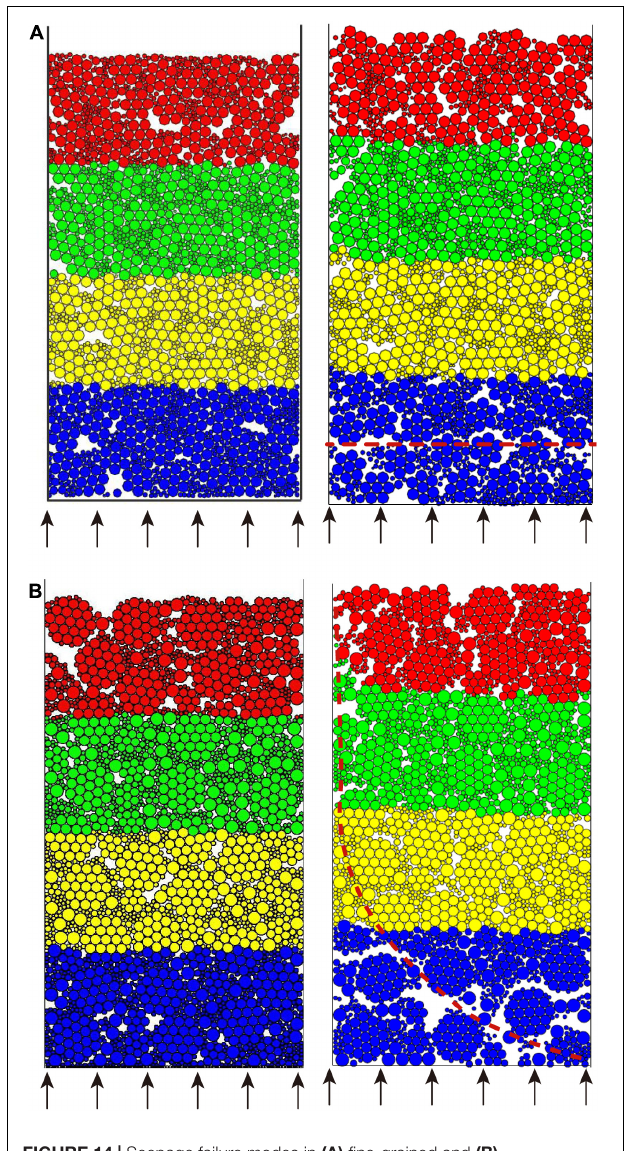
FIGURE 14 | Seepage failure modes in (A) fine-grained and (B) coarse-grained soils (Shi et al., 2018). The red dashed lines denote the seepage failure tendency. Flowing soil and piping failures occur for the fine-grained and coarse-grained soils,